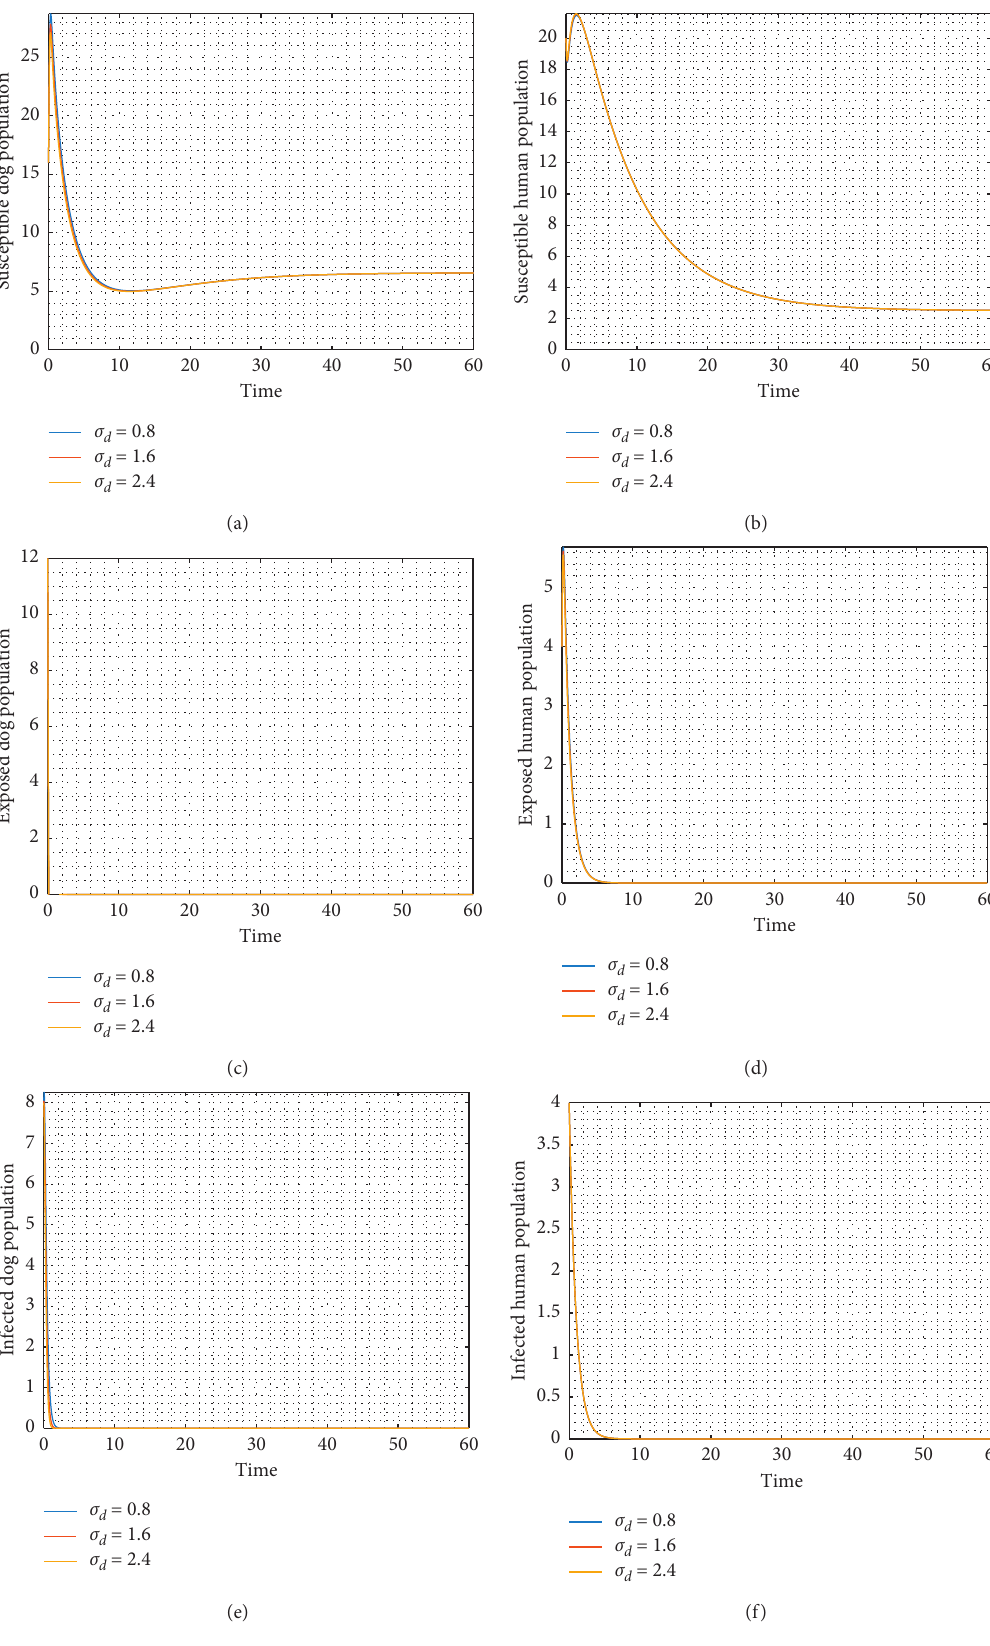
Figure 6: Solution curves of model (1) showing the effect of σ